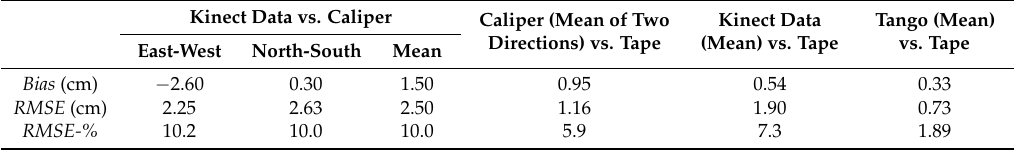
Table 2. Bias , root-mean-square error ( RMSE ) and RMSE-% of diameter between Kinect sensor data, tape measurements, measurements by caliper, or measurements with Tango device in Kirkkonummi, Finland. For Tango, the values are given for individual tree measurements. Kinect Data vs. Caliper Caliper (Mean of Two Kinect Data Tango (Mean) (Mean) vs. Tape Directions) vs. Tape vs. TapeEast-West North-South Mean Bias